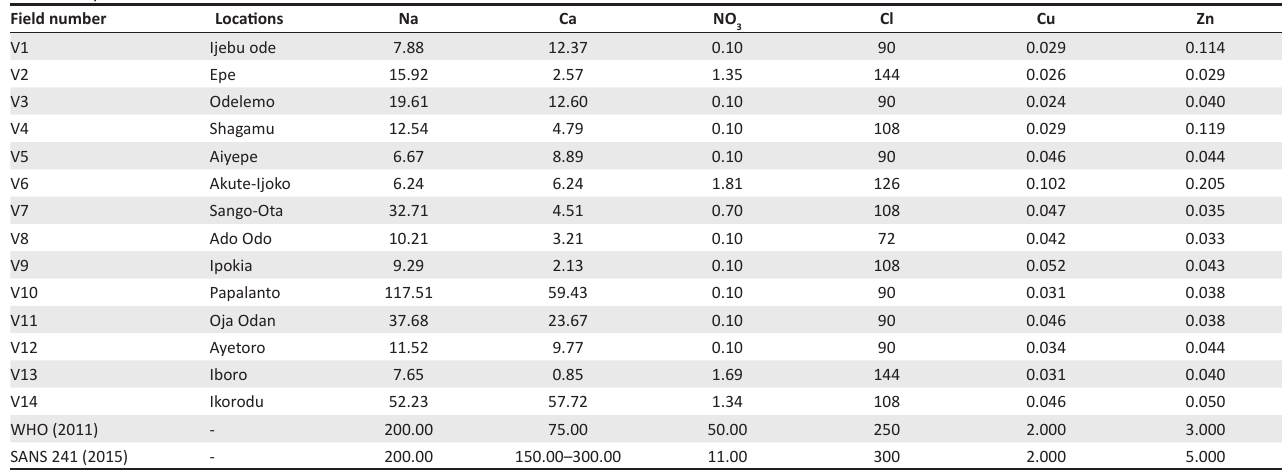
TABLE 7: Hydrochemical results of selected locations in the basin.